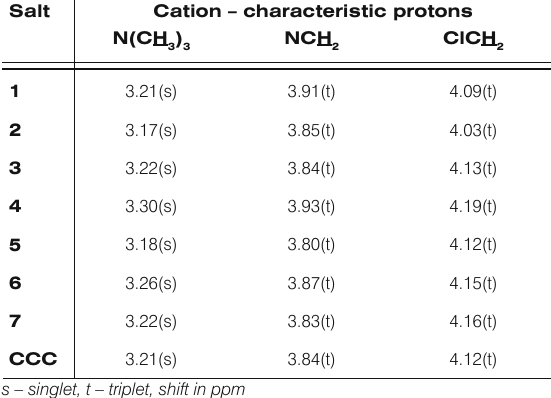
Table 2. The chemical shifts in 1 H NMR.